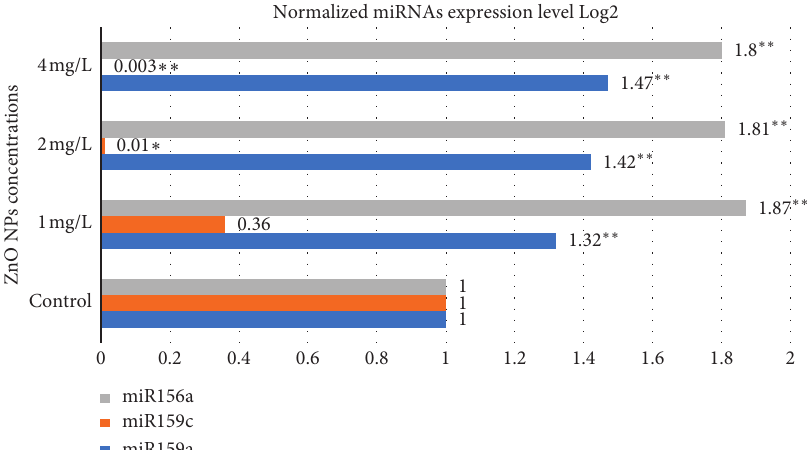
Figure 6: The results of the determination of miR156a, miR159a, and miR159c expression levels in control and experimental groups of barley ( H. vulgare L.) plants exposed to different concentrations of ZnO nanoparticles. Values are the mean of three replicates with SD. ∗ Significant difference from control ( p < 0 . 05); ∗∗ significant difference from control ( p < 0 .